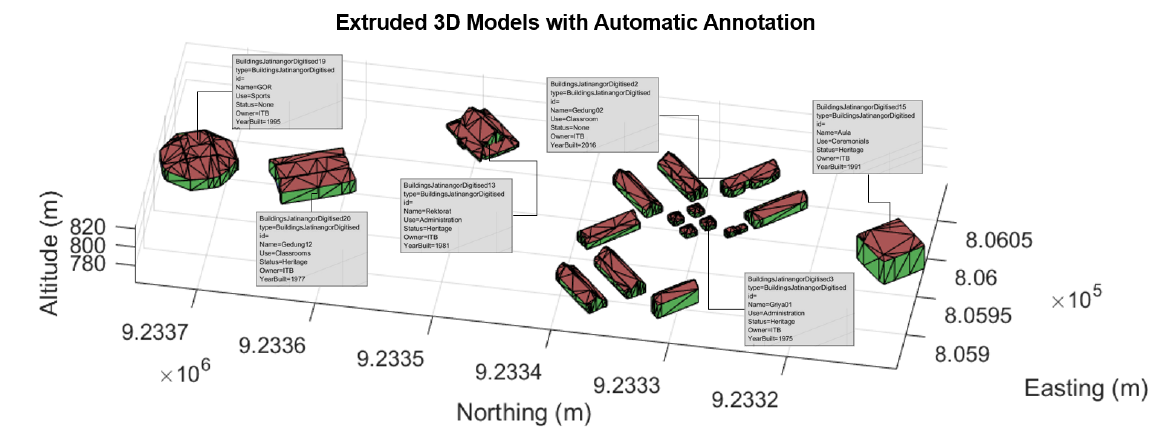
Figure 8. Illustration of the automatically annotated GIS attributes on the resulting building 3D models.